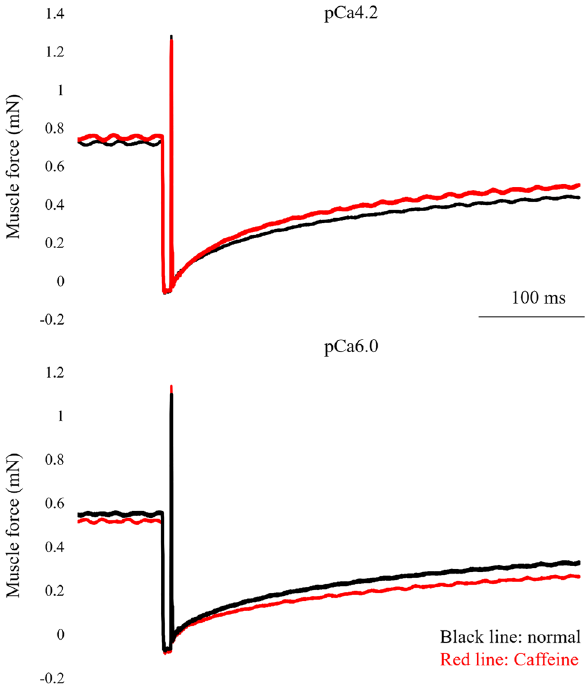
Figure 3. Force responses for the normal and caffeine conditions in the kTR protocol (force declines to zero by a quick shortening and redevelops by a subsequent quick restretch to the initial length). Black lines indicate the normal condition and red lines indicate the caffeine condition.